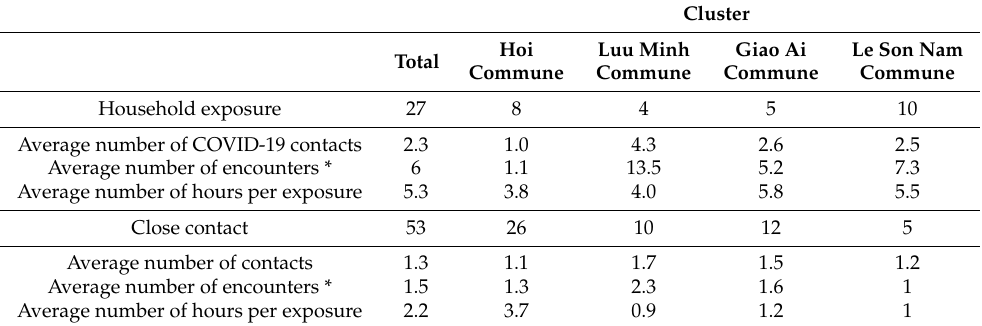
Table 2. Characteristics of exposure to COVID-19 cases by household and close contacts.